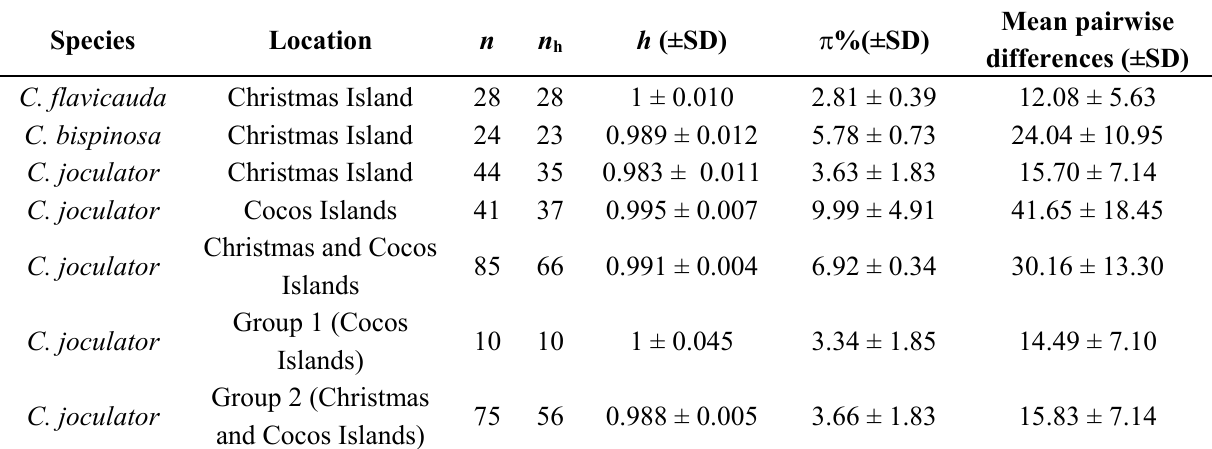
Table 1. Genetic diversity measures for the endemic Centropyge joculator from Christmas and Cocos Islands, and for the widespread species C. bispinosa and C. flavicauda from Christmas Island.